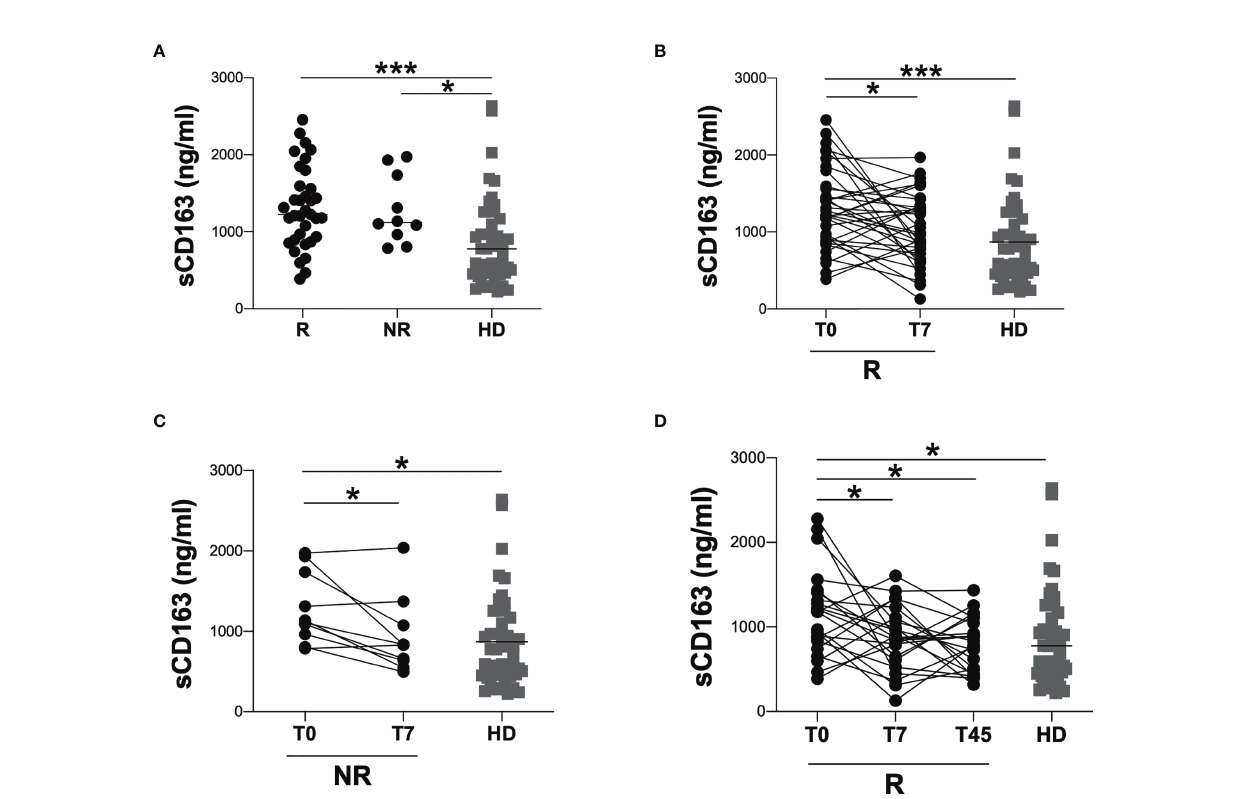
FIGURE 3 | Evaluation of sCD163 plasmatic levels according to response to tocilizumab treatment. (A) sCD163 plasmatic levels were evaluated in 35 responder (R) and 10 non-responder (NR) patients. The differences were evaluated using the nonparametric Mann-Whitney test. Data are shown as median (lines). Both R and NR groups were compared to HD using the nonparametric Kruskal-Wallis test with Dunn ’ s post-test. Data are shown as median (lines). (B) sCD163 plasmatic levels were longitudinal evaluated in 35 responder (R) patients at two time-points: at T0 (on hospital admission) and T7 (after seven days from hospital admission) using Wilcoxon test. Both T0 and T7 were compared to HD using the nonparametric Kruskal-Wallis test with Dunn ’ s post-test. Data are shown as median (lines). (C) sCD163 plasmatic levels were longitudinal evaluated in 10 non-responder (NR) patients at two time-points: at T0 (on hospital admission) and T7 (after seven days from hospital admission) using Wilcoxon test. Both T0 and T7 were compared to HD using the nonparametric Kruskal-Wallis test with Dunn ’ s post-test. Data are shown as median (lines). (D) sCD163 plasmatic levels were longitudinal evaluated in 22 responder (R) patients at three time-points: at T0 (on hospital admission), T7 (after seven days from hospital admission) and T45 (30-45 days from discharge) using Friedman test with Dunn ’ s post-test. Each time-point (T0, T7 and T45) was compared to HD using the nonparametric Kruskal-Wallis test with Dunn ’ s post-test. Data are shown as median (lines). ***0.0001<p<0.001;